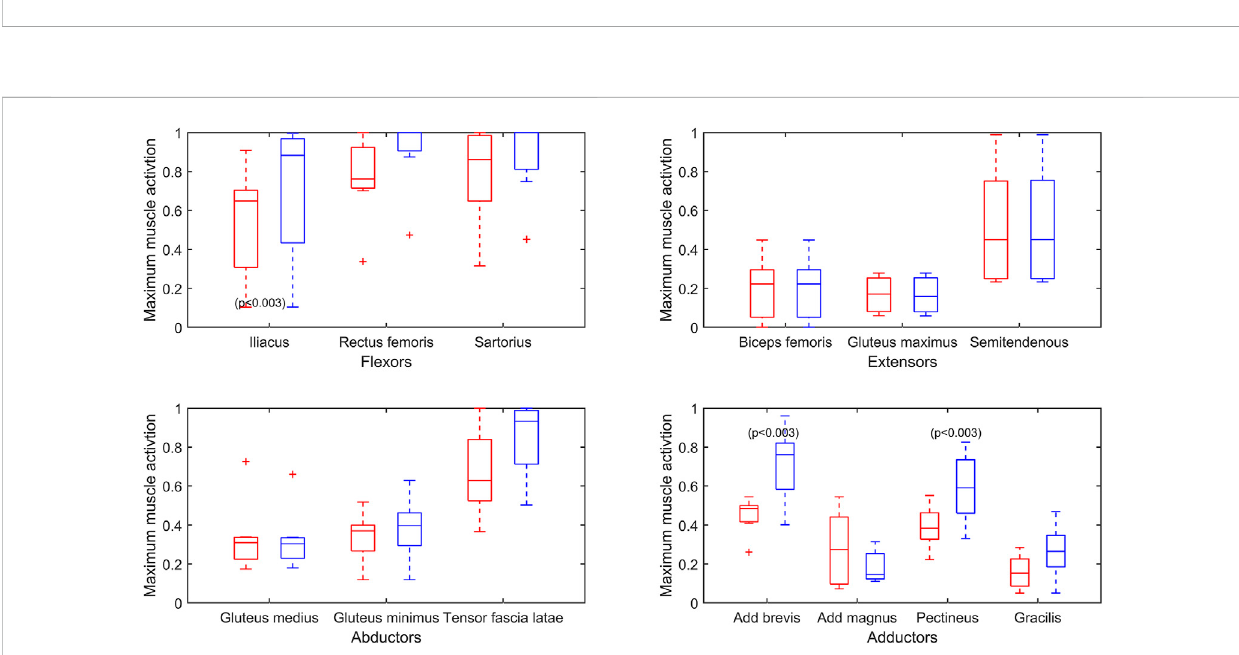
FIGURE 5 Maximum muscle activation (force/ F i max ) over a gait cycle for bilateral transfemoral persons with limb loss participants (baseline in red, reduced endurance state in blue). Baseline values are plotted for only legs for which a feasible solution could be found in the reduced endurance state. A reduced endurance state simulated by a reduction in the maximum capacity of the psoas major and the adductor longus is shown. Muscles are grouped into primary function; p values are presented on a plot for signi fi cant difference between the means of baseline and the reduced endurance